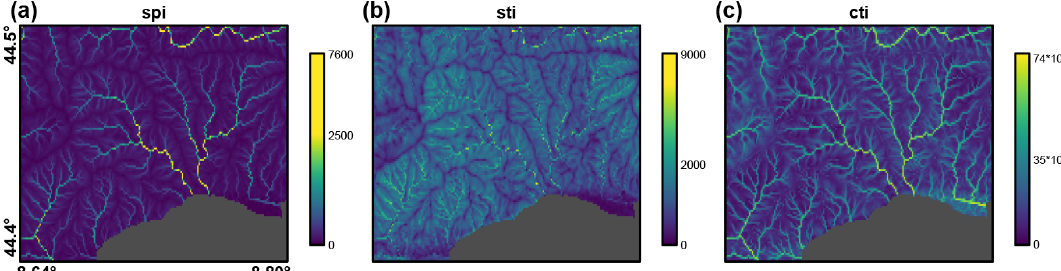
Figure 15. Different flow index layers computed using flow accumulation and terrain slope. Map (a) shows the stream power index (spi), map (b) sediment transport index (sti), and map (c) compound topographic index (cti). The panel letters correspond to those in Table